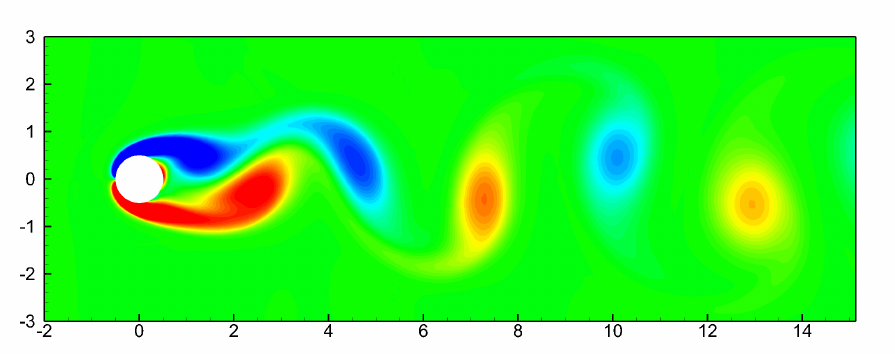
Figure 5. A snapshot of the vortex field for Re = 100 and n = 1.8.